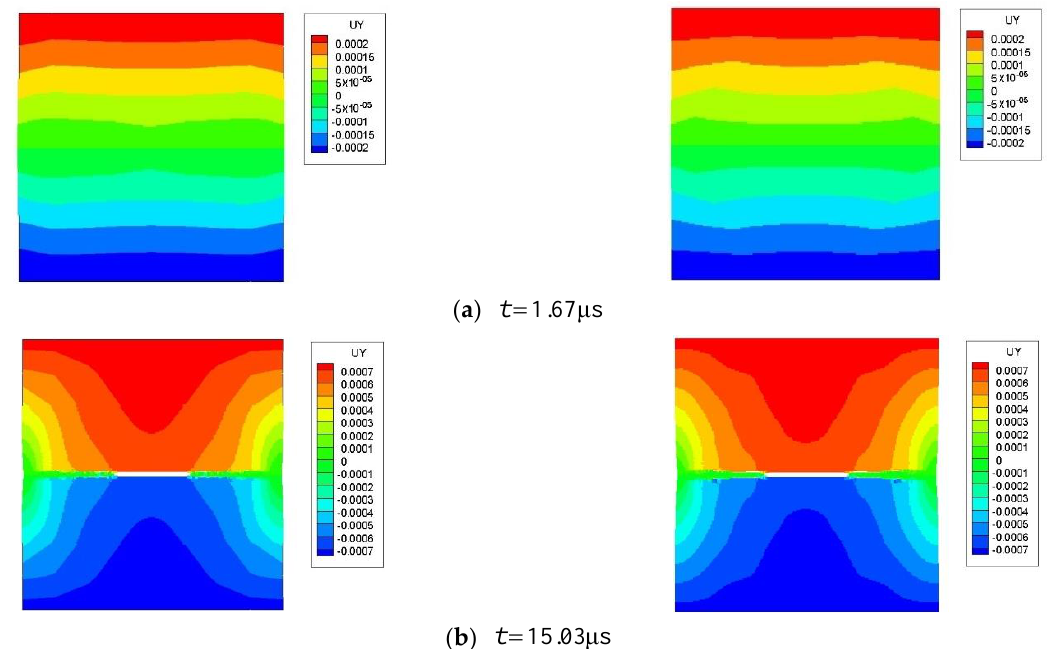
Figure 8. Vertical displacement simulations, left : FEM-PD coupling model; right : PD model.